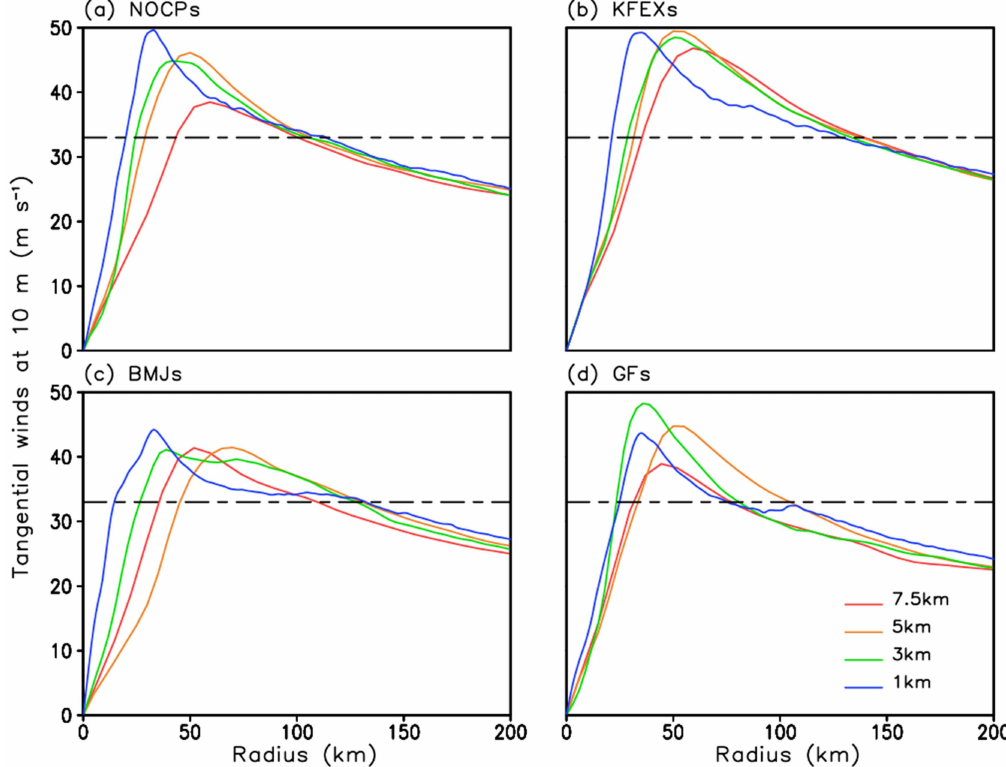
Figure 8. Radial distributions of the azimuthal-mean tangential wind (m s − 1 ) at 10-m height in the TC mature stage simulated by ( a ) NOCPs, ( b ) KFEXs, ( c ) BMJs, ( d ) GFs. The dash line represents 33m s − 1